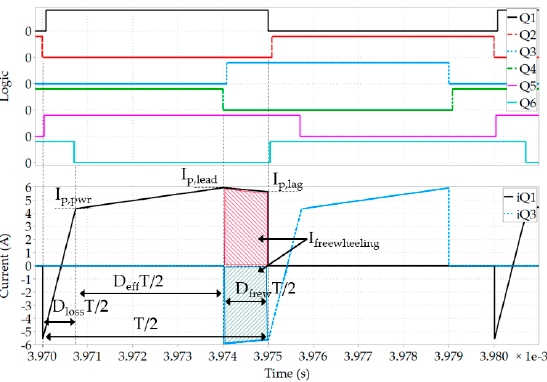
Figure 3. Primary side HV MOSFETs current and PWM control signals of a simplified model of a PSFB converter.